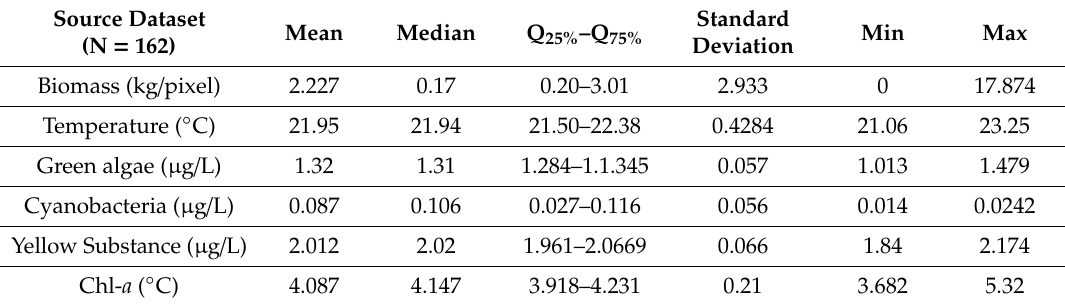
Table 1. Descriptive statistics of Landsat 5 regression tree training dataset.